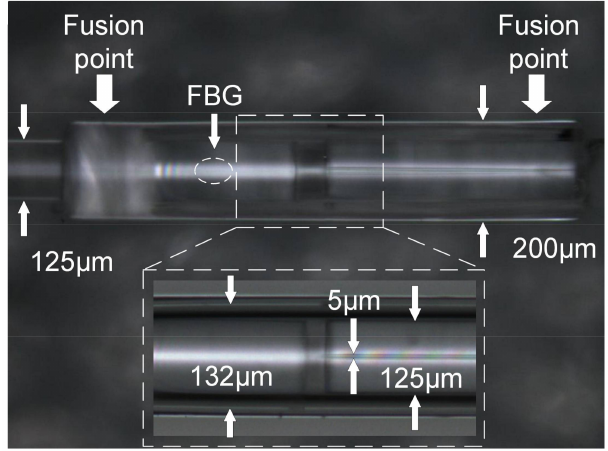
Figure 3. Microscopic image of the fiber-optic FP gas pressure